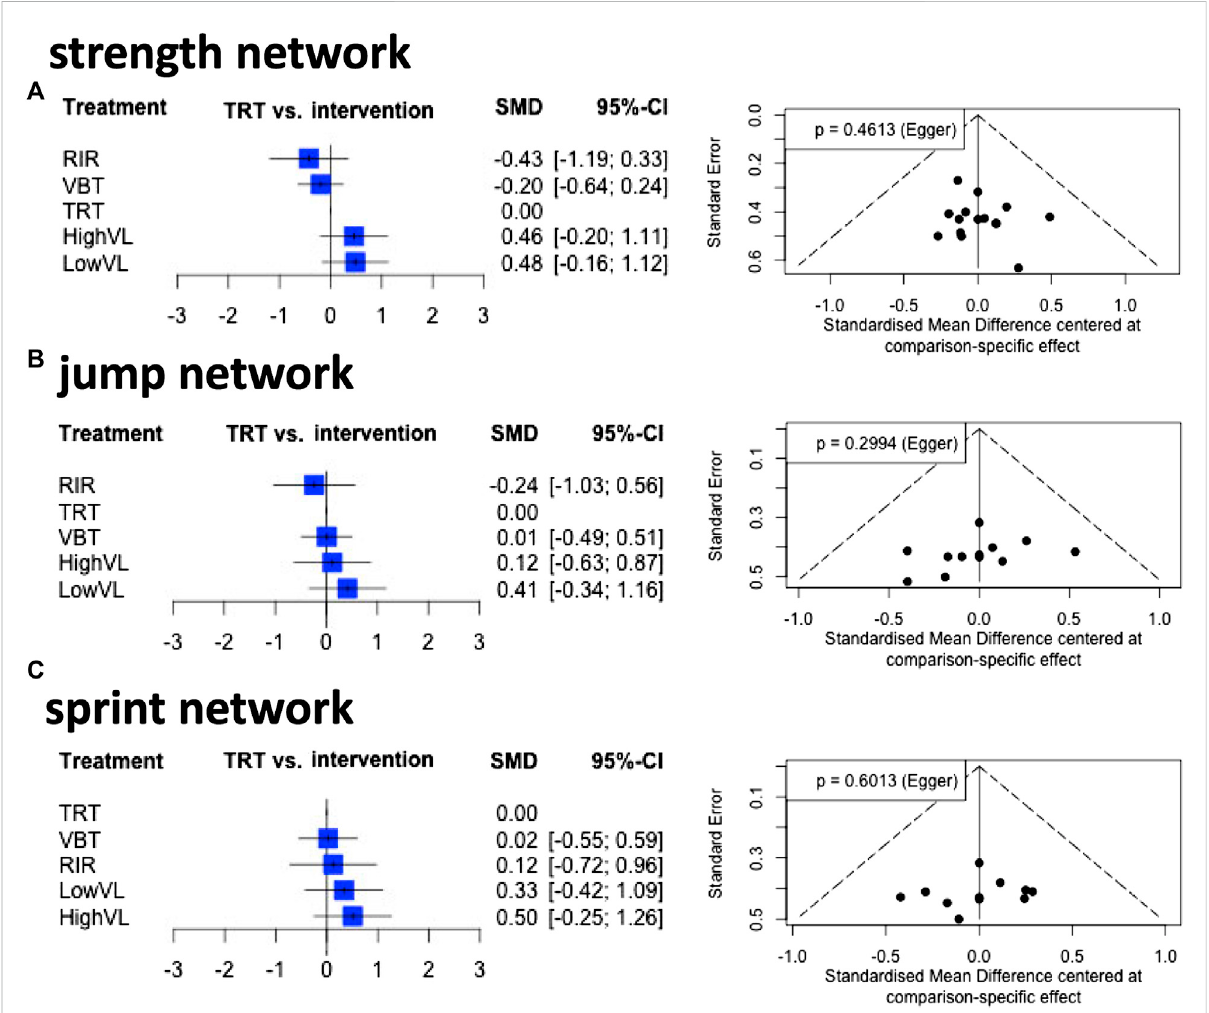
FIGURE 4 Forest and funnel plots for the strength (A) , jump (B) , and sprint (C) network. In addition, Egger´s p scores are given. LowVL: low velocity loss ( ≤ 20%); HighVL: high velocity loss ( > 20%); RIR: repetitions in reserve-based training; VBT: velocity-based resistance training; TRT: traditional 1RM based resistance training